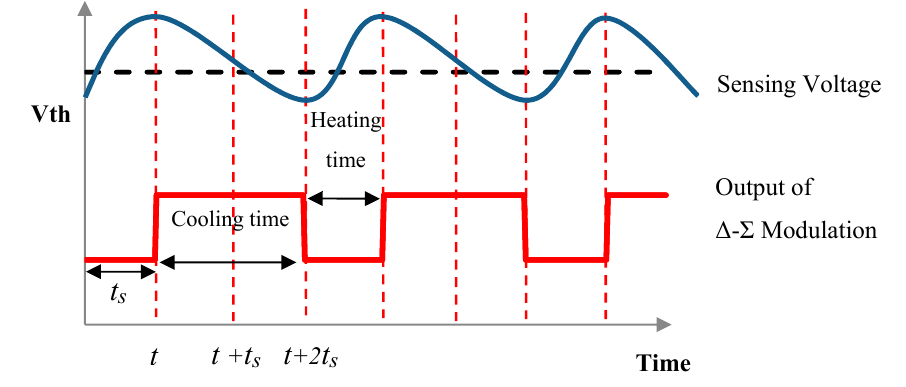
Figure 3. Working principle of Δ - Σ modulation architecture.